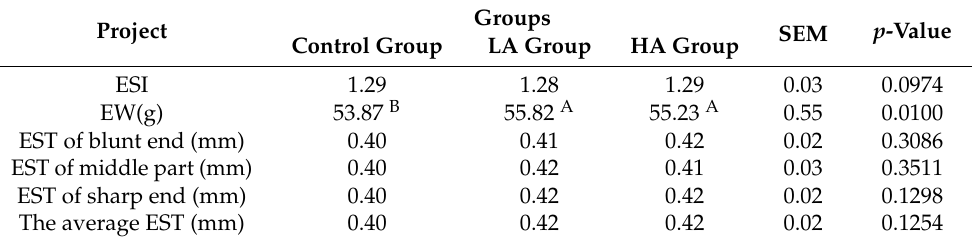
Table 4. Effects of dietary-supplemented Gynostemma pentaphyllum on the physical indexes of the